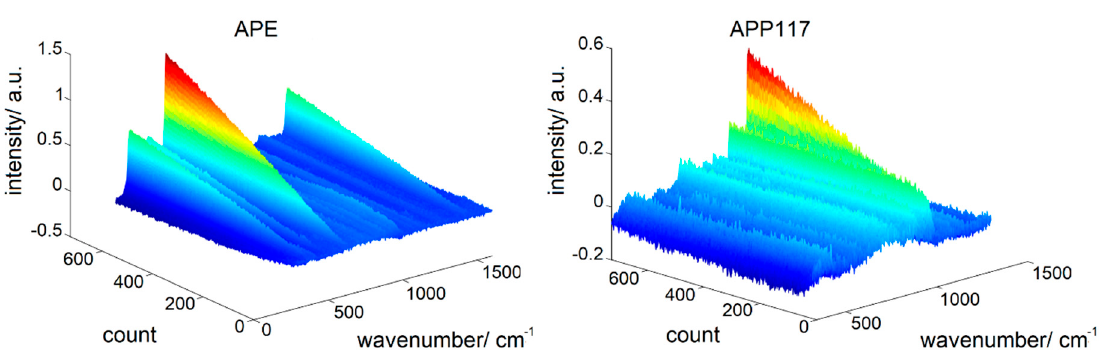
Figure 5. SNV-preprocessed di ff erential spectra during the application of APE and APP117 on the placebo cores.